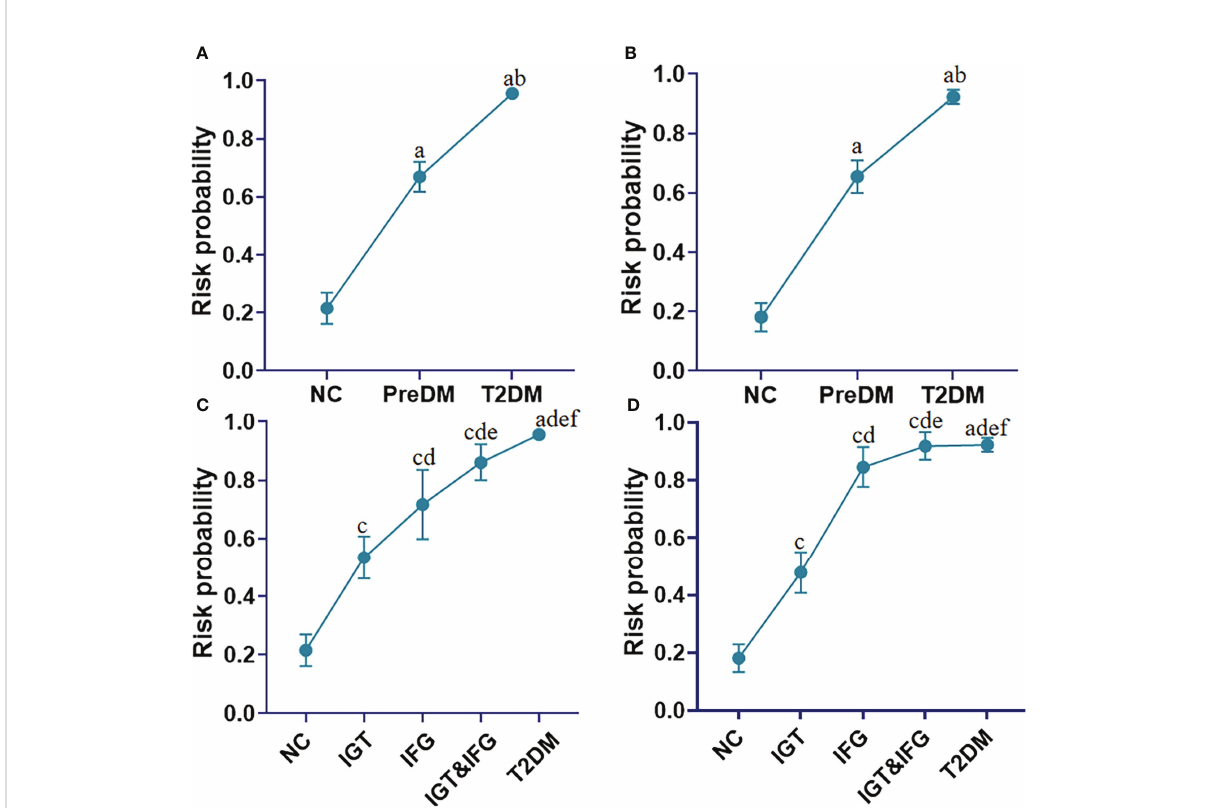
FIGURE 5 Line charts present the risk probability of developing into T2DM in the cohorts of the NC, PreDM and T2DM in the discovery (A) and validation (B) sets based on addition of FA 18:2, FA 20:2, SM 32:1, SM 40:7, PC 32:0, PC 38:7, PC 40:6 to Age, BMI, and FPG; Line charts present the risk probability of developing into T2DM in the cohorts of the NC, subgroups of PreDM including IGT to IFG to IFG&IGT, and T2DM in the discovery (C) and validation (D) sets based on addition of FA 18:2, FA 20:2, SM 32:1, SM 40:7, PC 32:0, PC 38:7, PC 40:6 to Age, BMI, and FPG. a P < 0.05, when T2DM and PreDM are compared with NC; b P < 0.05, when T2DM is compared with PreDM, c P < 0.05, when IGT, IFG and IGT&IFG is compared with NC, d P < 0.05, when IFG, IGT&IFG and T2DM is compared with IGT, e P < 0.05, when IGT&IFG and T2DM is compared with IFG, f P < 0.05, when T2DM is compared with IGT&IFG. Data represent mean with 95%